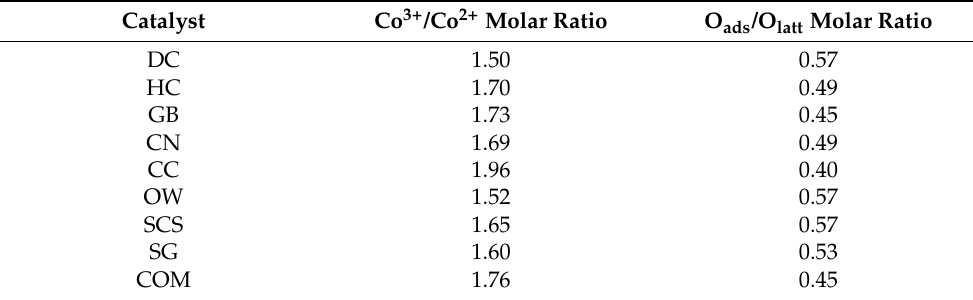
Table 2. Surface composition of the bulk Co 3 O 4 catalysts.